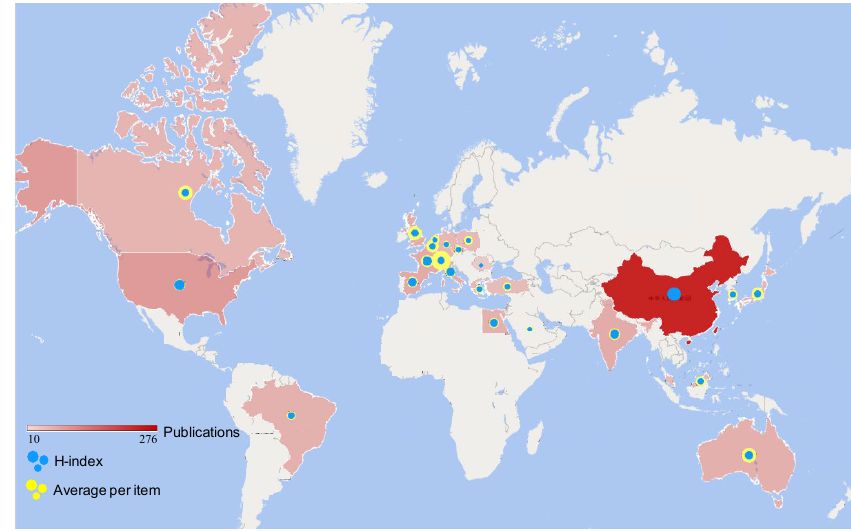
Figure 2. Publication distribution map of the top twenty-five productive countries.